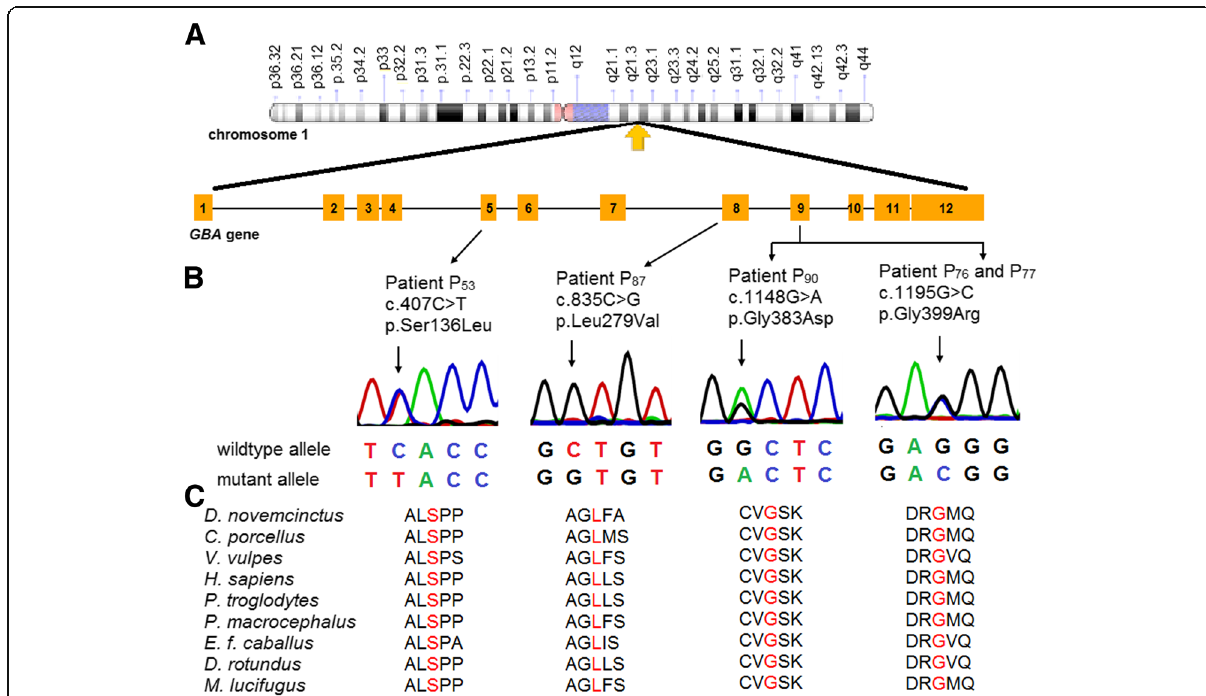
Fig. 2 Identification of novel variants in GBA1 gene. a Illustrative representation of the distributions of the novel variants identified in Indian Gaucher patients investigated in this study. b Sanger sequencing discovered four missense variants in GBA1 gene. The variants p.Ser136Leu, p.Gly383Asp, and p.Gly399Arg, were identified, as compound heterozygotes along with another know mutant allele. The variant p.Leu279Val existed in homozygous form. An arrow indicates the point of variation. c The multiple alignment of the protein sequence surrounding the novel variants against various orthologous sequence revealed the conservative status of the wildtype residues (marked